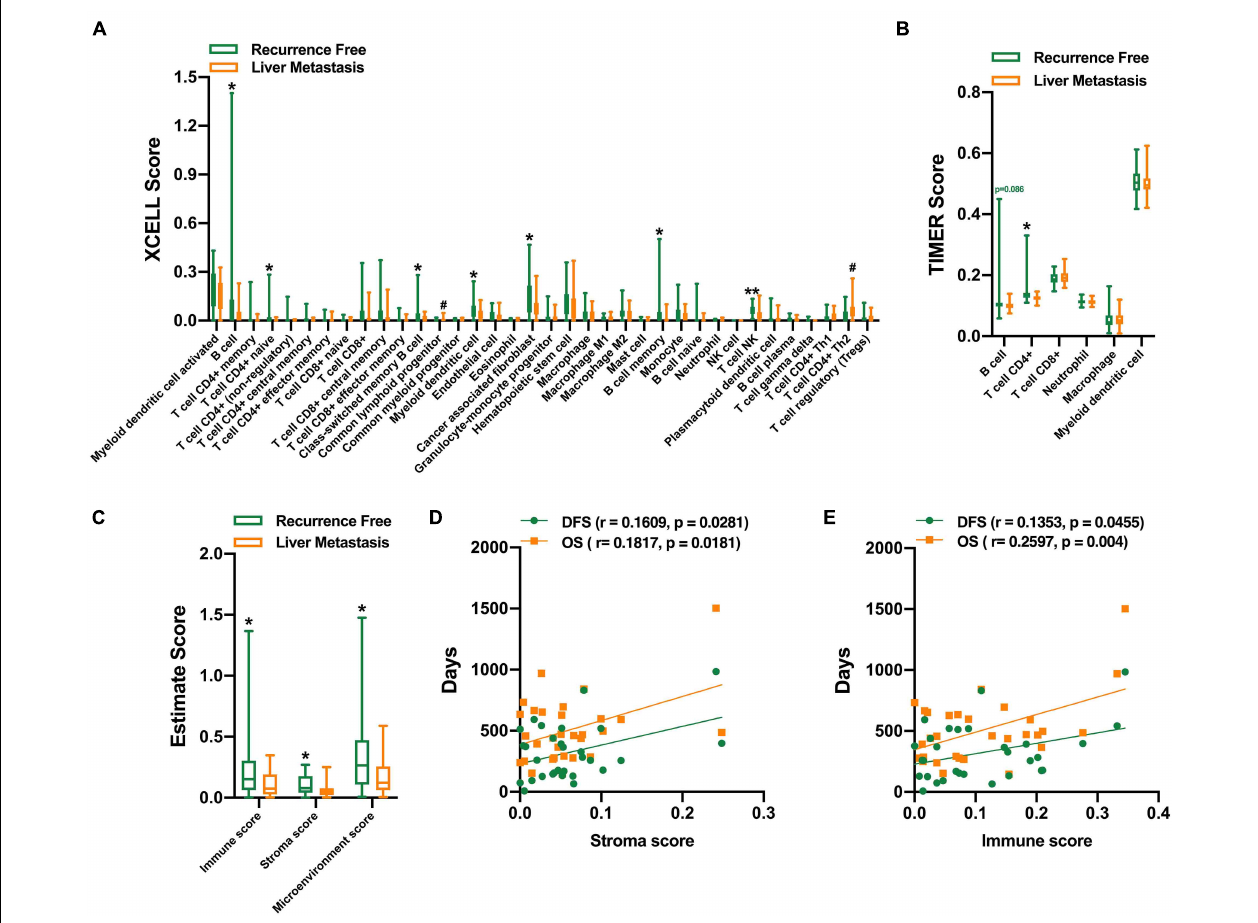
FIGURE 4 | Evaluation of the infiltration level of immune cells. XCELL (A) , TIMER (B) , and ESTIMATE score of the two groups (C) . Positive correlation between stroma score (D) , immune score (E) , and the DFS and OS in the liver metastasis group. * , # P < 0.05, ** P <